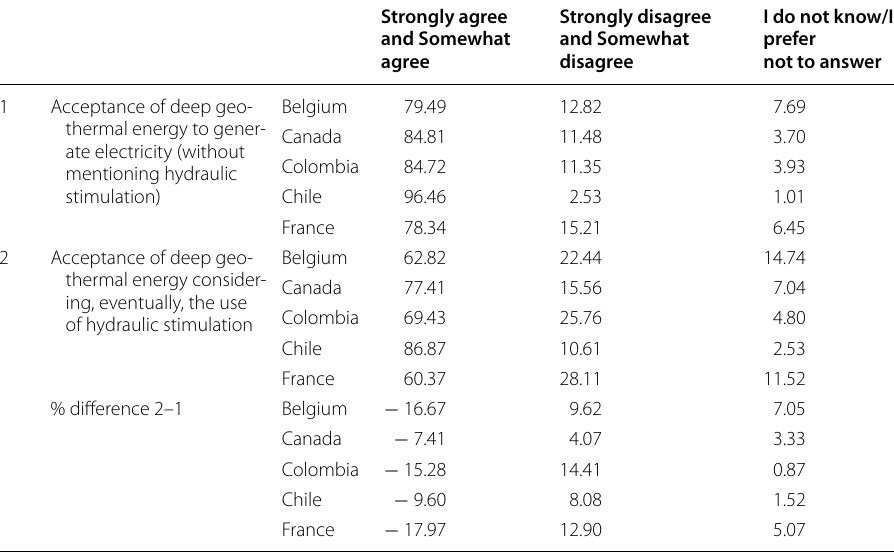
Table 3 Acceptance of geothermal energy for electricity generation, with and